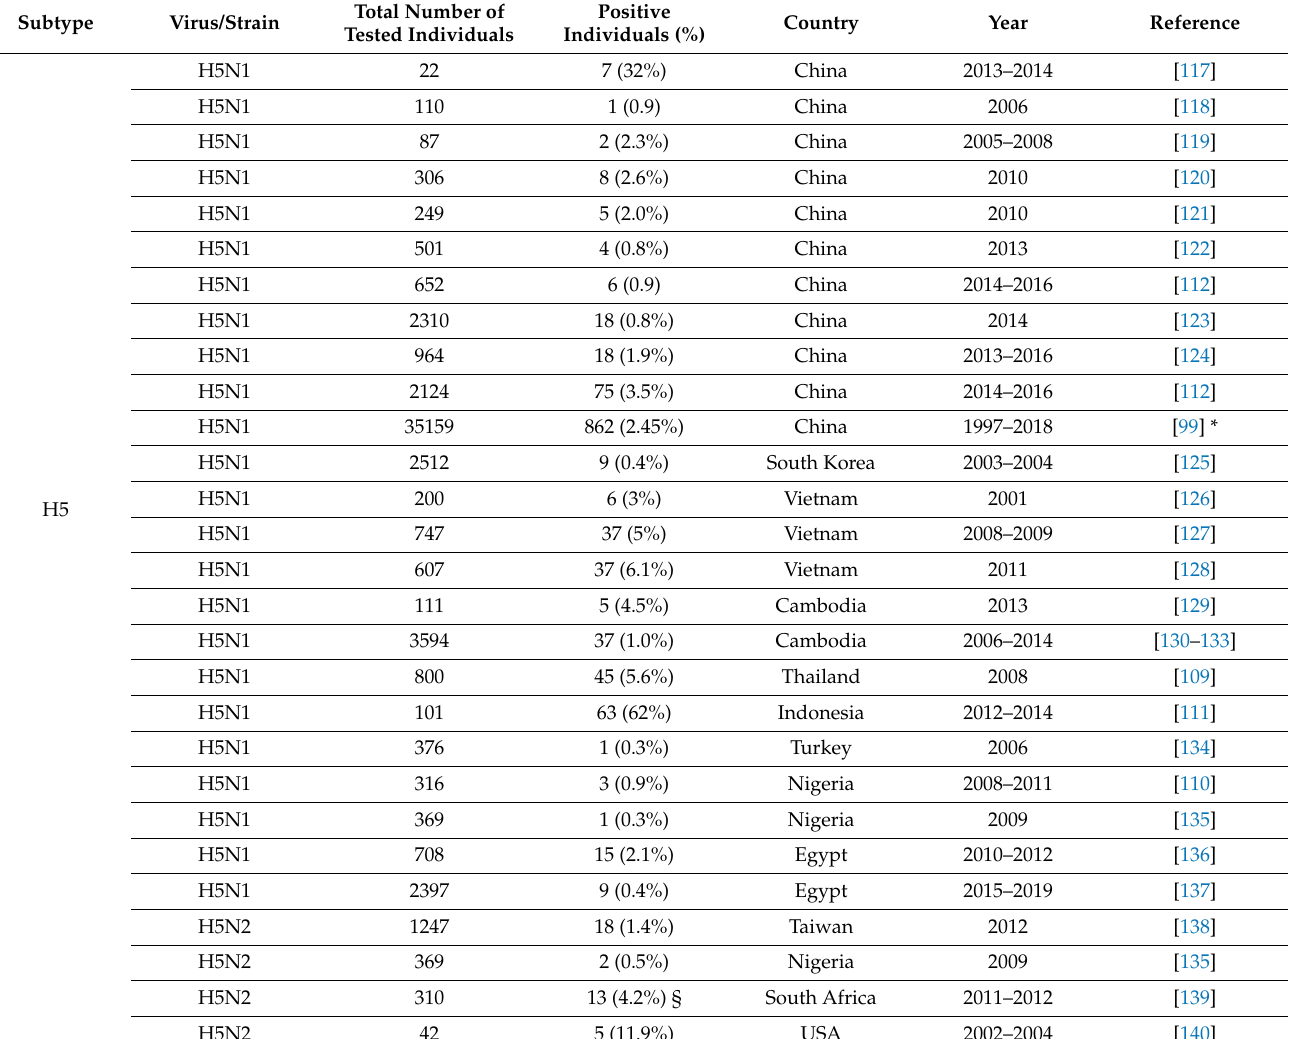
Table 2. Examples for potential subclinical human infections with AIV H5, H7, and H9